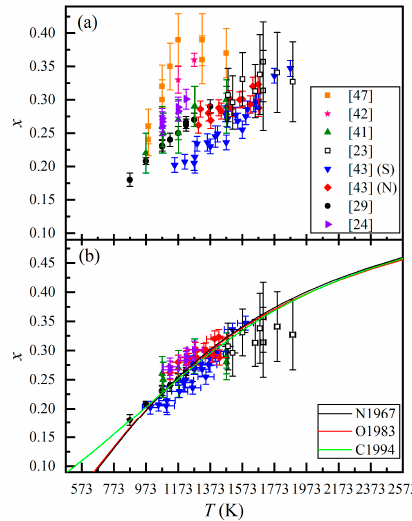
Figure 5. ( a ) Correlations between temperature ( T ) and x of the MgAl 2 O 4 -spinel from equilibrium experiments, in which the cation exchange reaction closely reached its equilibrium and the cation order-disorder state was perfectly preserved by the quenching process. ( b ) Correlations between temperature ( T ) and x of the MgAl 2 O 4 -spinel from equilibrium experiments, with further temperature correction, data comparison, and selection (see text for the details). Two samples, sample S and sample N, were investigated by Redfern et al. [43]. N1967 = the Navrotsky and Kleppa thermodynamic model [49], O1983 = the O’Neill and Navrotsky thermodynamic model [50], C1994 = the Carpenter and Salje thermodynamic model [51]. Accurate temperature measurement is critical. Both Wood et al. [47] and Andreozzi et al. [29] used the Pt-Rh thermocouple to measure their experimental temperatures. The Pt-Rh thermocouple is applicable for the T range of 323–2041 K [52], with a precision of ~ ± 5 K in the T range of 873–973 K and ~ ± 10 K for higher temperatures [29]. Millard et al. [41] did not mention their thermocouple